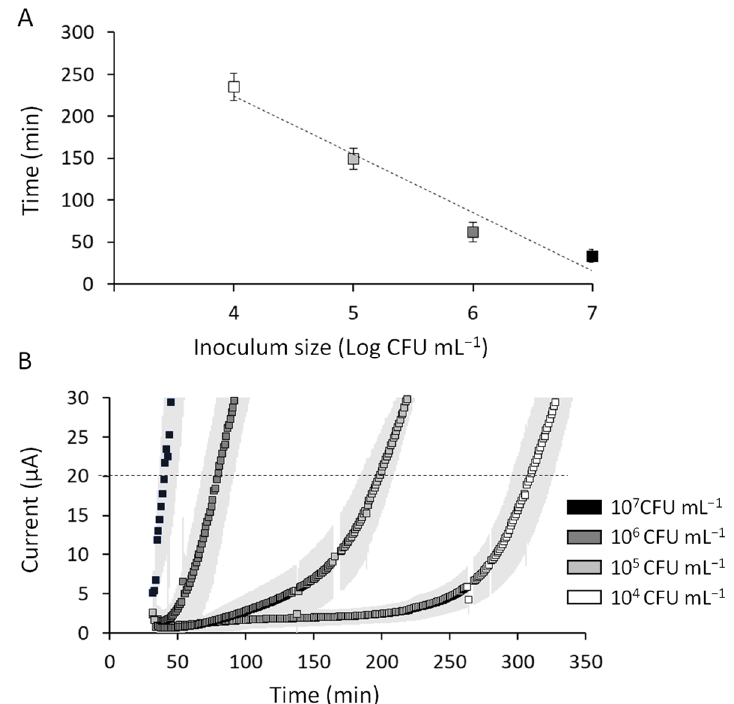
Figure 2. ( A ) Calibration curve for E. faecalis detection showing detection time (minutes) with inoculum size as log CFU mL − 1 (r 2 = 0.96). ( B ) Chronoamperometry curves of corresponding inoculum sizes and from which calibration curve is derived. The dotted line corresponds to the thresholdof detection.. Mean values are shown, error bars correspond to the standard deviation of three replicates and are represented by bars ( A ) or by the shaded area ( B ).